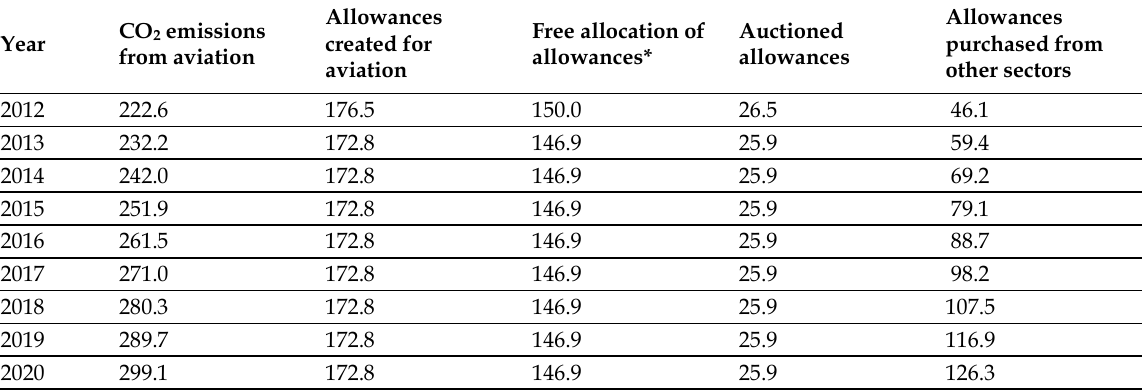
Table 2. Development of EU ETS for aviation key determinants in the timeframe 2012-2020, in million